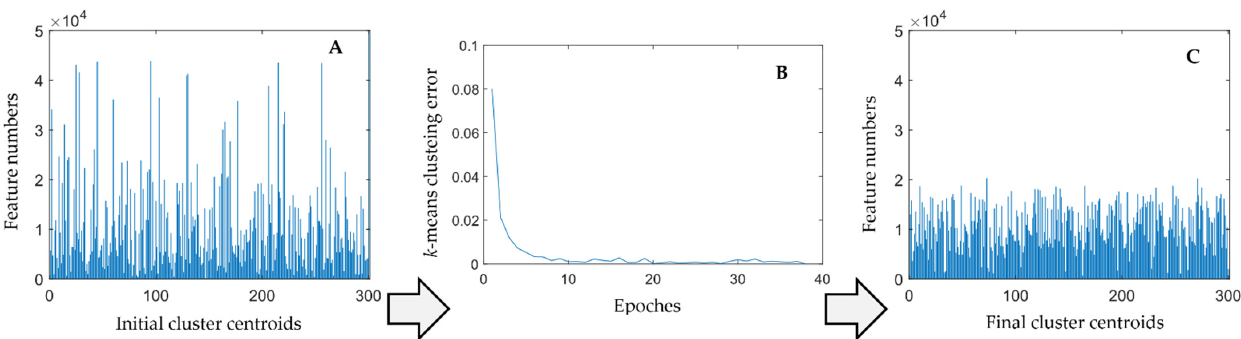
Figure 4. Change of k (as 300) cluster centroids and corresponding assignments after several iterations. ( A ) is the initial clustering result using k -mean++ algorithm, ( B ) shows the training processes of k -means clustering, and ( C ) is the final clustering result.